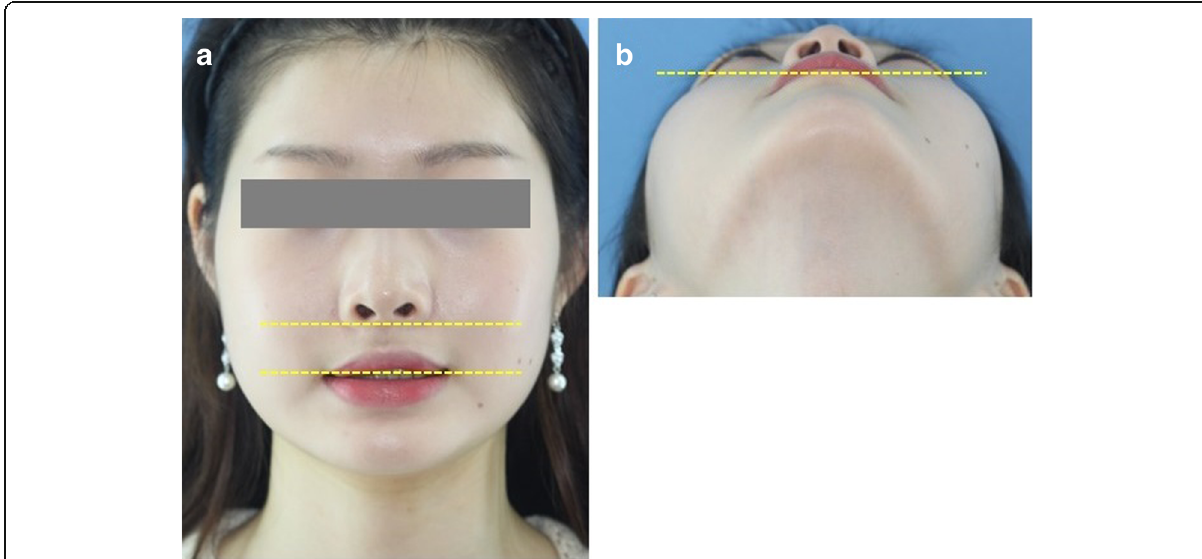
Fig. 7 Appearance at 1 year ’ s follow-up showing symmetry of the face. a , b Postoperative photographs showed that the deviation of the ala base and mouth corner was almost resolved. Note the improved facial symmetry and contour of the right maxillary